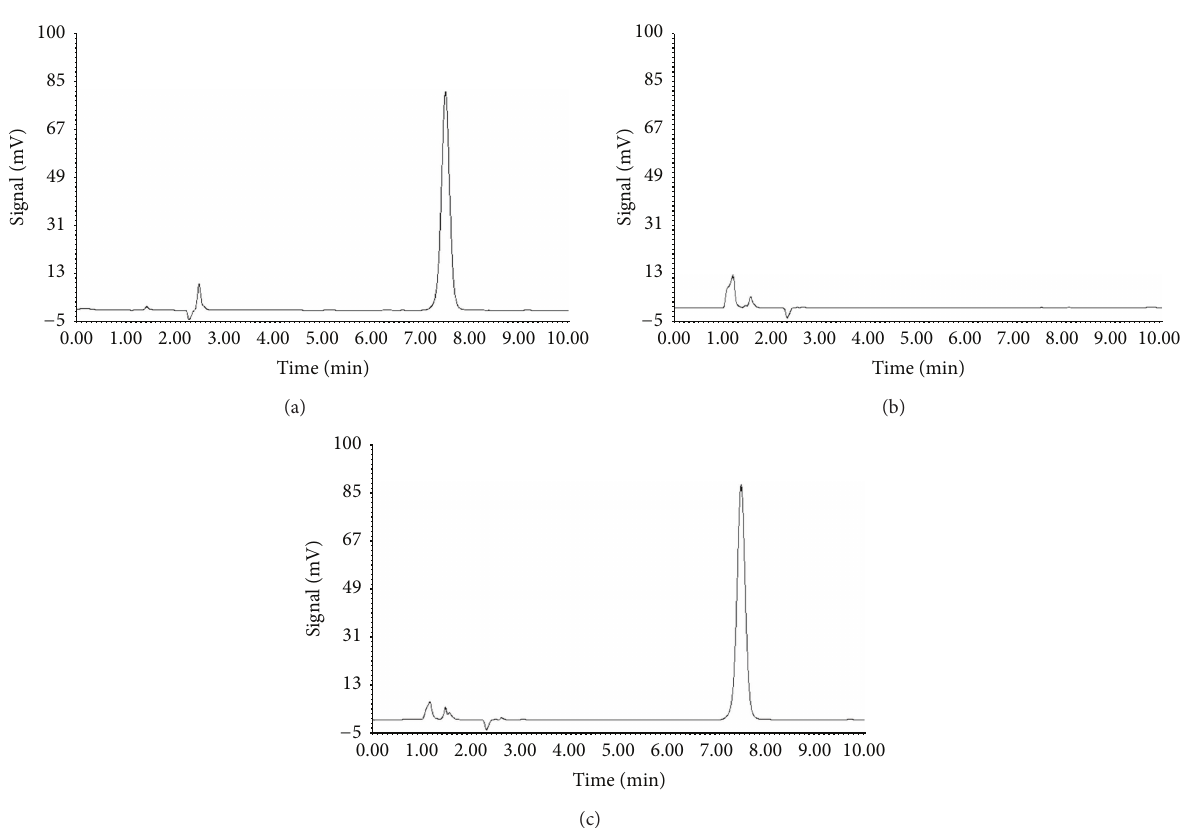
Figure 2: Chromatograms of (a) nimodipine (RT = 7.50); (b) blank excipients sample, and (c) sustained release tablets